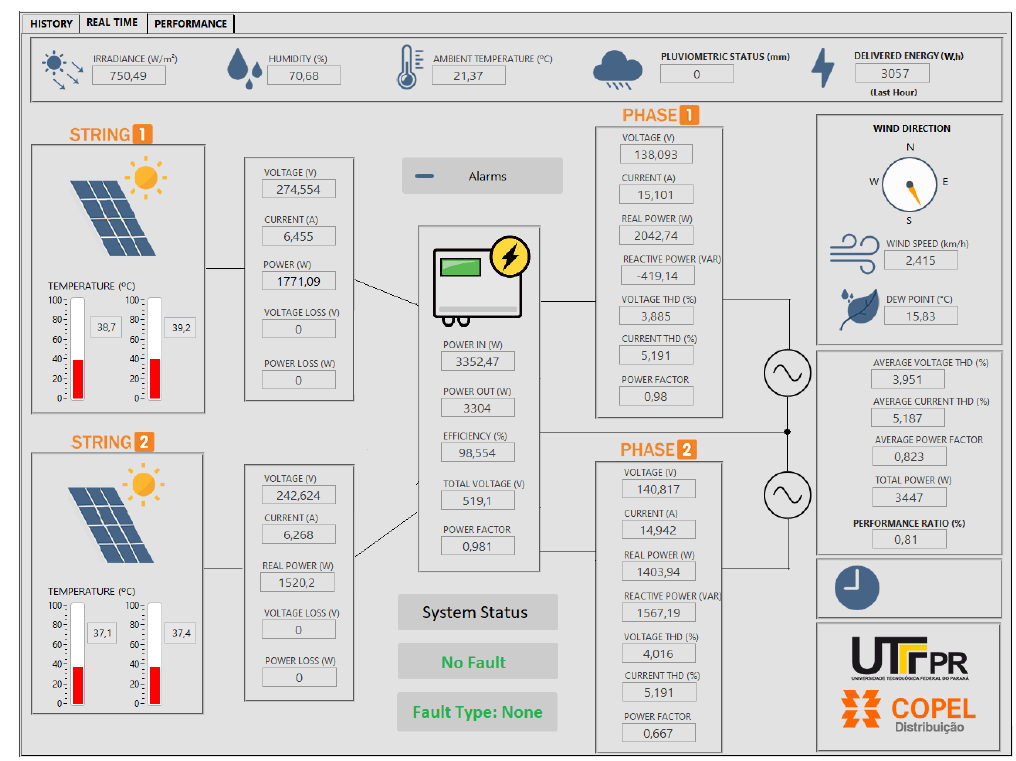
Figure 14. Human Machine Interface (HMI) Screen showing the real time measurements and the current status of the monitored PV